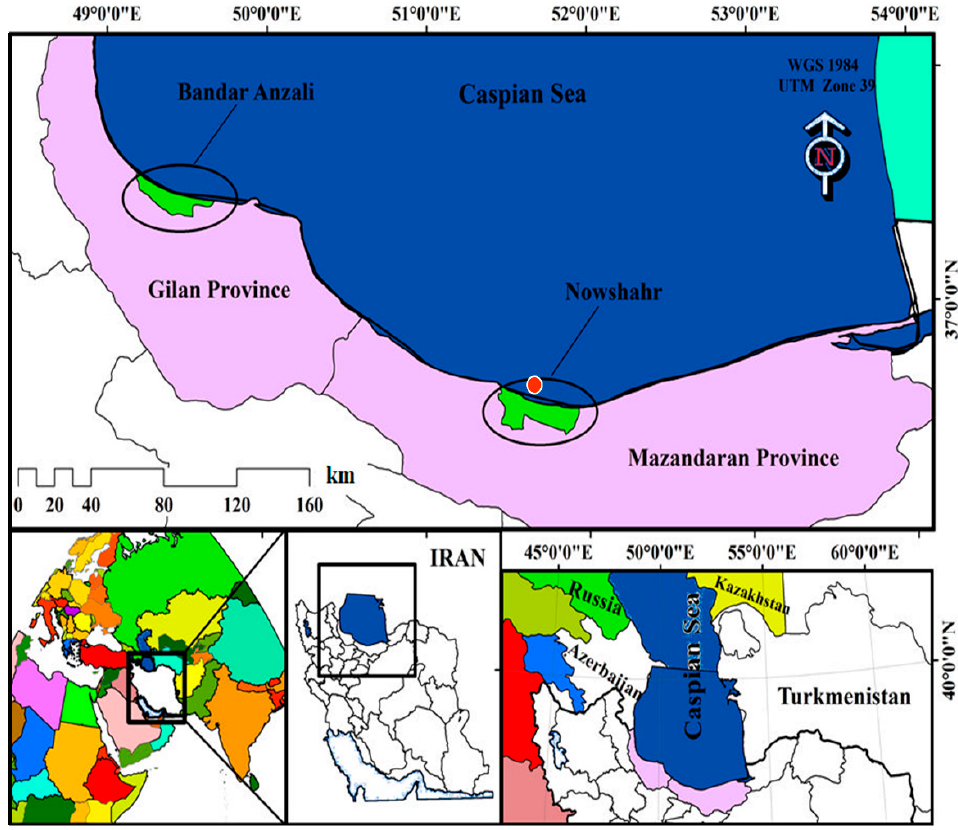
Figure 1. Detailed map of southern coasts of the Caspian Sea area, with a wide overview of the locations of Nowshahr buoy station (northern Iran). Additionally, an overview of all countries surrounding southern Caspian Sea area (Azerbaijan, Iran, Kazakhstan, Russia, and Turkmenistan) is reported in Figure 1. The orange marker indicates the location of Nowshahr buoy.